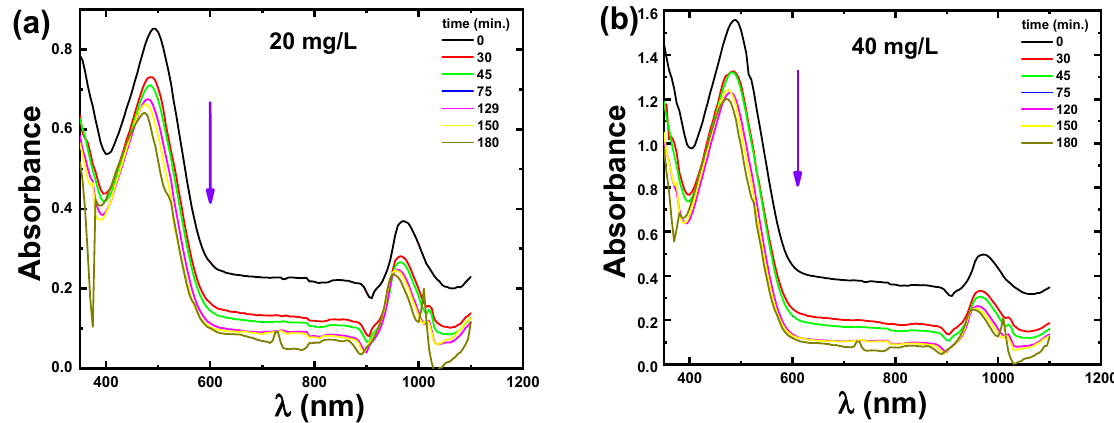
Figure 3. UV–visible absorption spectra of the ZnS nanoparticles for ( a ) 20 mg/L CR and ( b ) 40 mg/L CR dye at different shaking times. The inserted arrow shows the direction of the increase of shaking time.